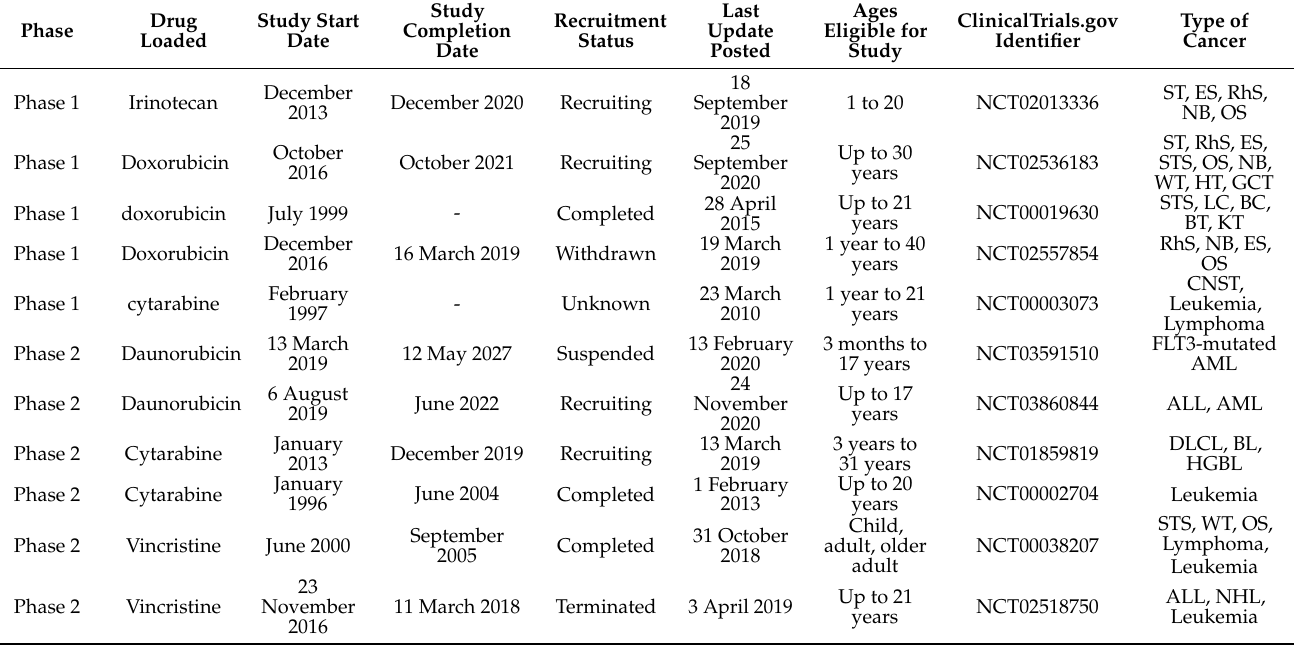
Table 1. Liposome formulations under clinical trial for pediatric cancer